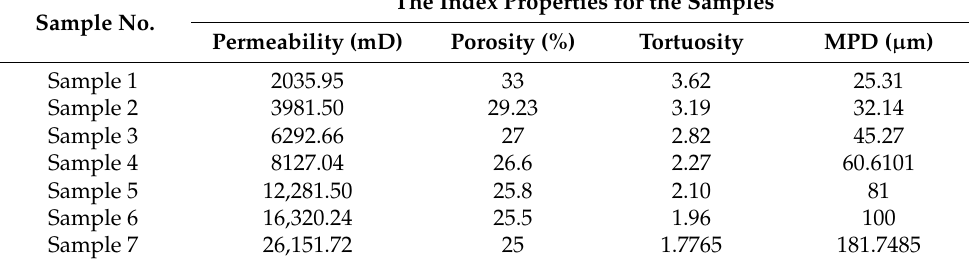
Table 2. Properties for the